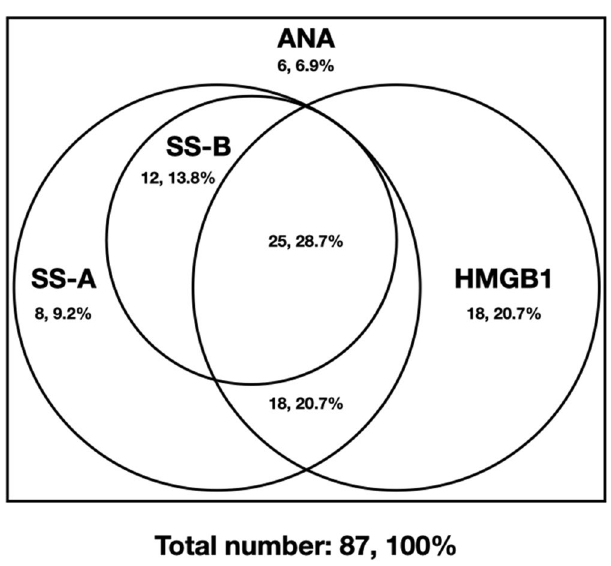
Figure 2. The overlap of anti-HMGB1, anti-SS-A, and anti-SS-B in ANA-IF positive SS